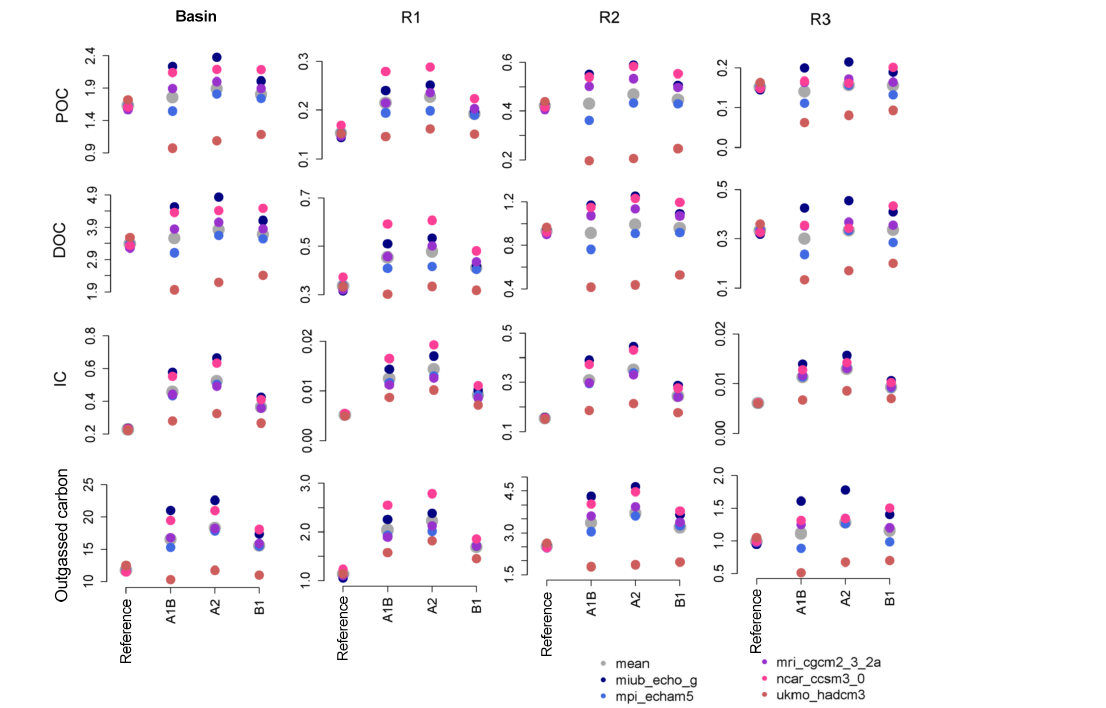
Figure 5. Mean annual sums of carbon pools (10 12 g) for the whole basin and three subregions for the reference period (1971–2000) and the future period (2070–2099, SRES A1B, A2 and B1). Each for five climate models and